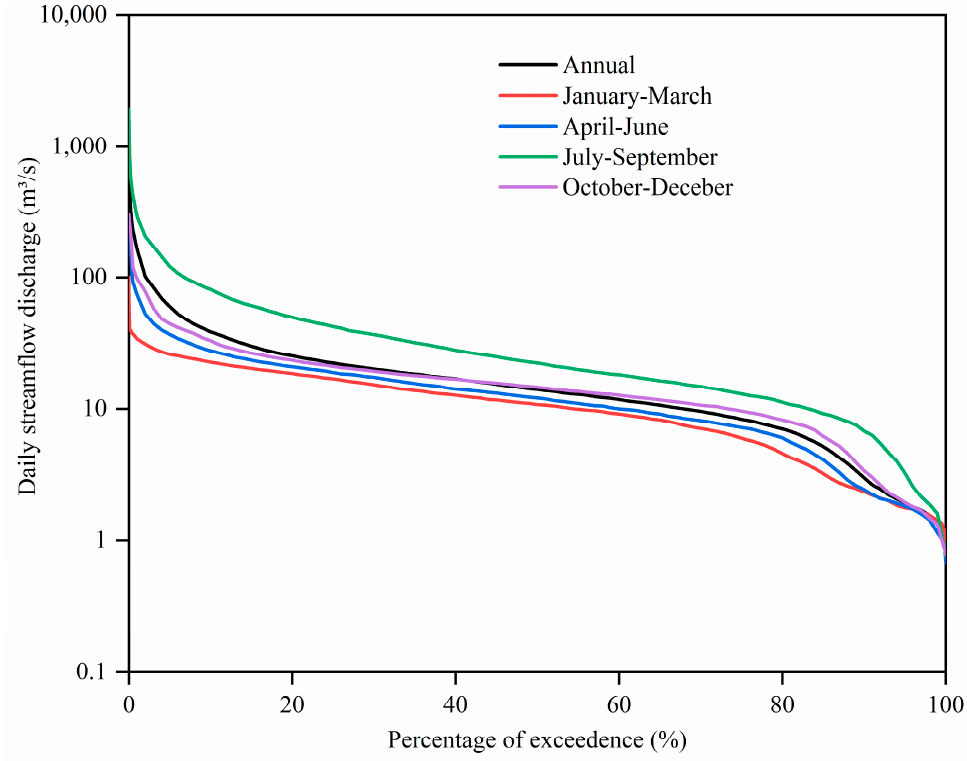
Figure 3. Daily FDCs of the annual and different quarter streamflow records at the Beiluo River Basin. Table 3. Characteristics of daily FDCs of streamflow in the Beiluo River Basin.